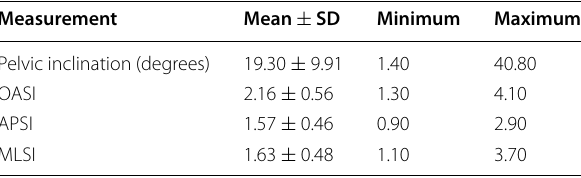
Table 3 Descriptive statistics of pelvic inclination and standing balance in studied children